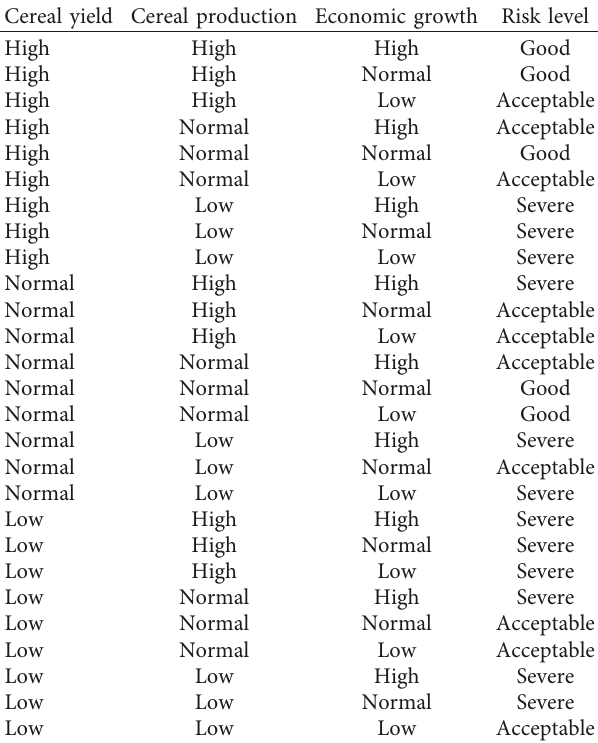
Table 1: Fuzzy knowledge